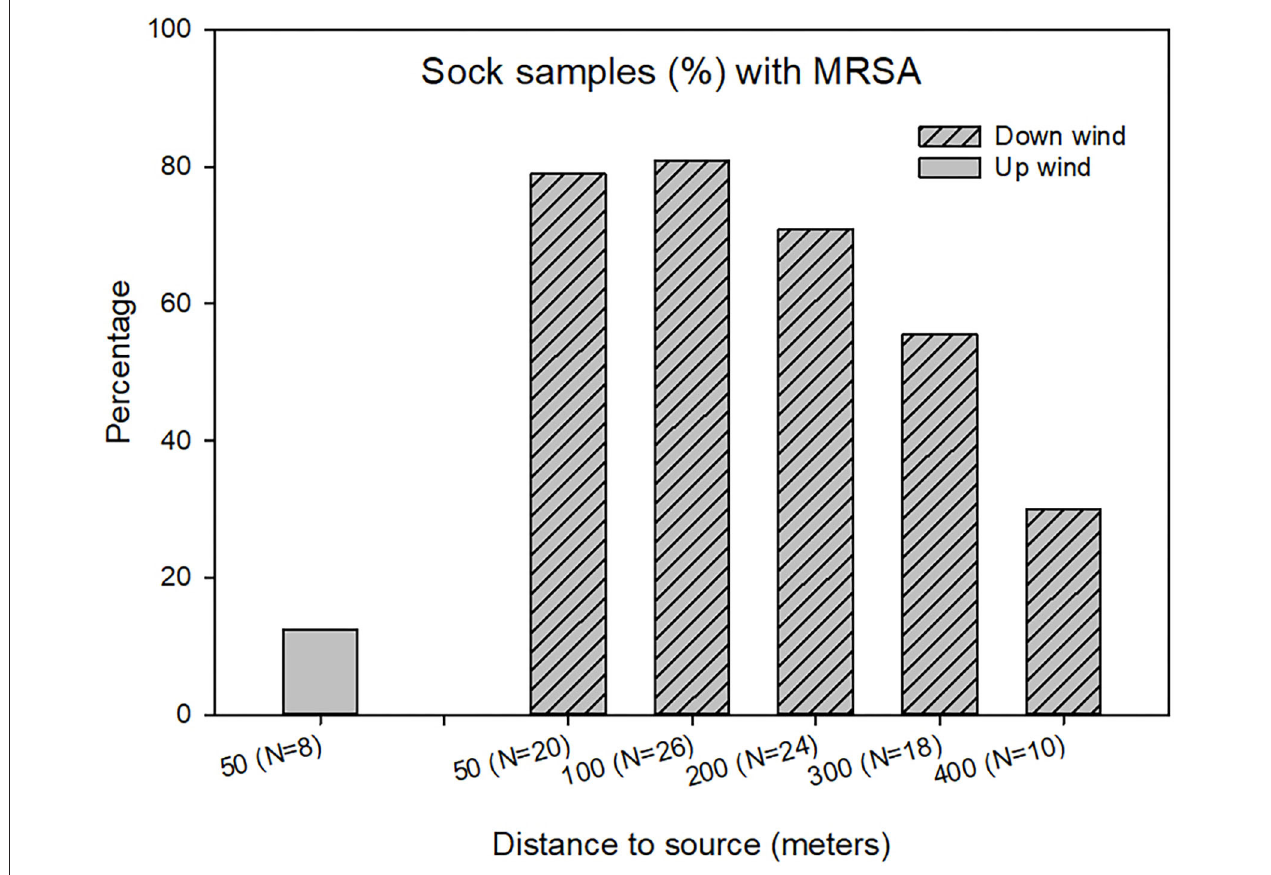
FIGURE 4 | LA-MRSA detected in sock samples outside the swine farm using data from seven samplings. N = number of samples at each